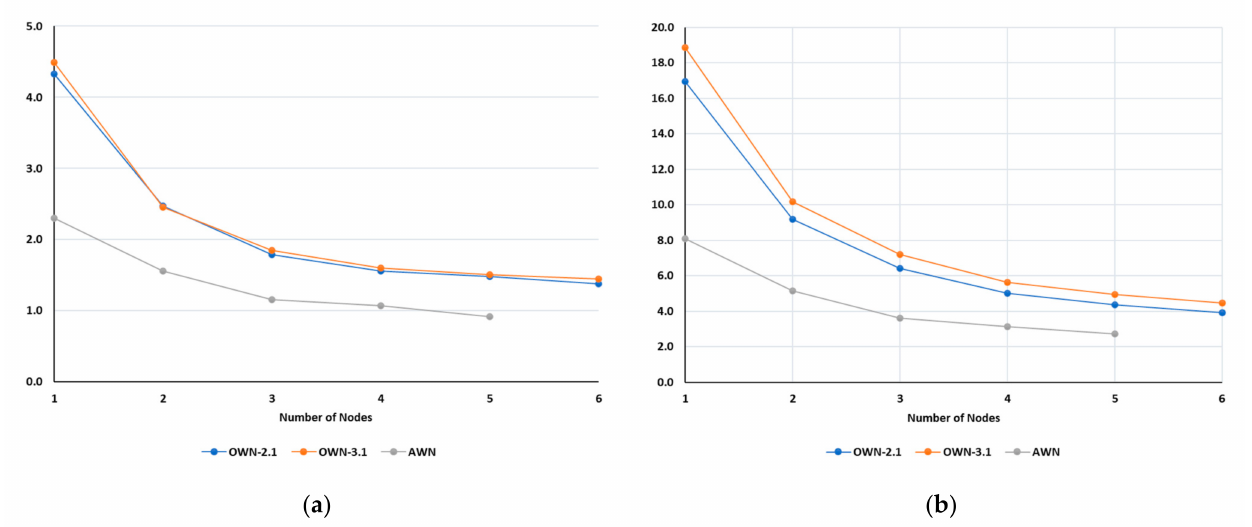
Figure 4. Processing time with the number of multi-nodes in the ALC and OCI for ( a ) small and ( b ) large datasets.